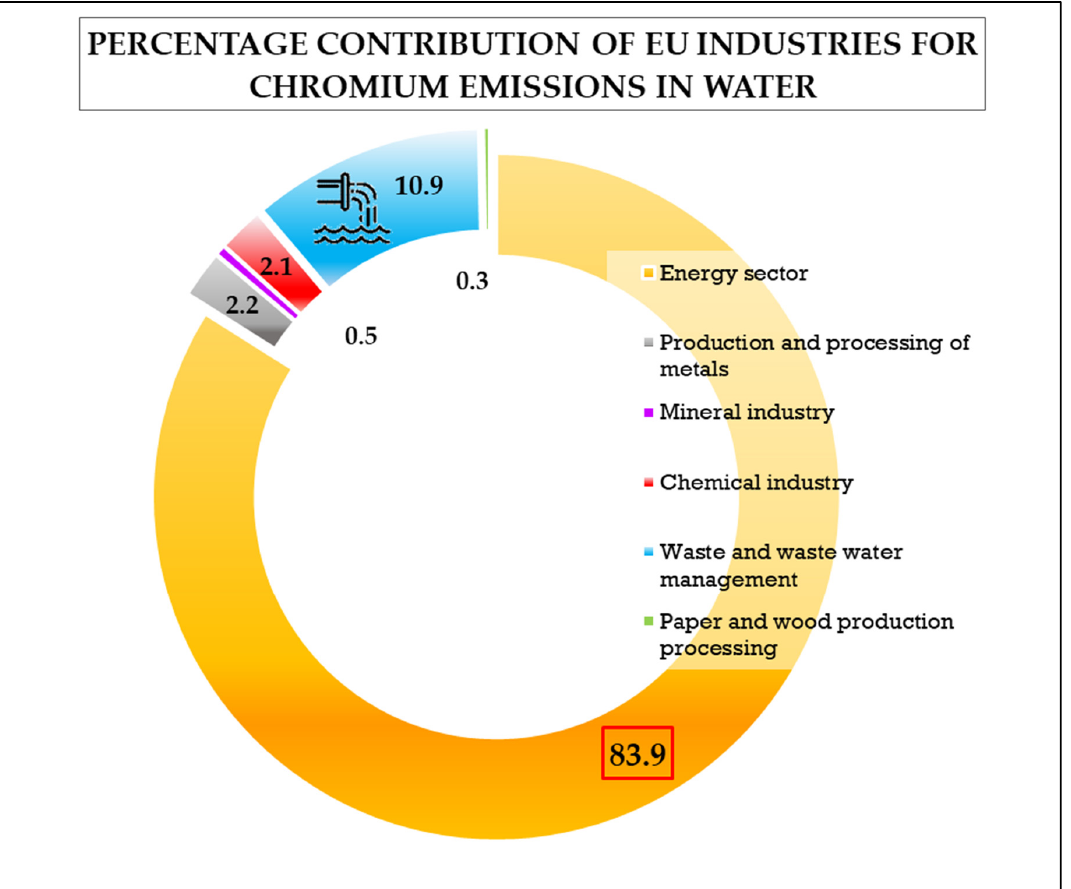
Figure 2. Percentage of Cr emission in EU waters per industrial sector. Data released by the European Environmental Agency are related to the year 2017 (data source: [44]).